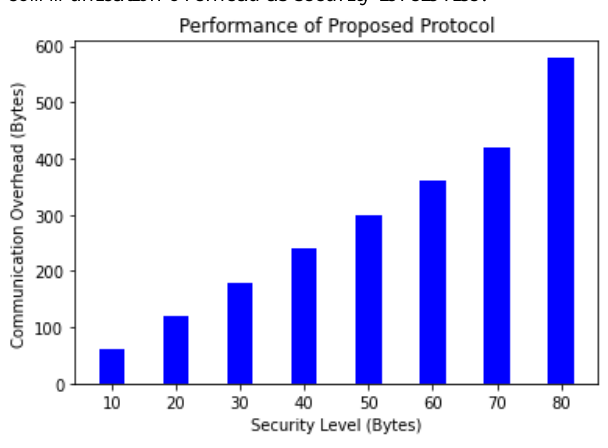
Figure 4. Performance of Proposed Protocol